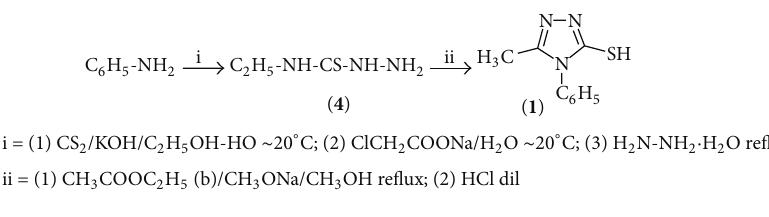
Scheme 1: The synthesis of 4 H -3-mercapto-5-methyl-4-phenyl-1,2,4-triazole ( 1 ).